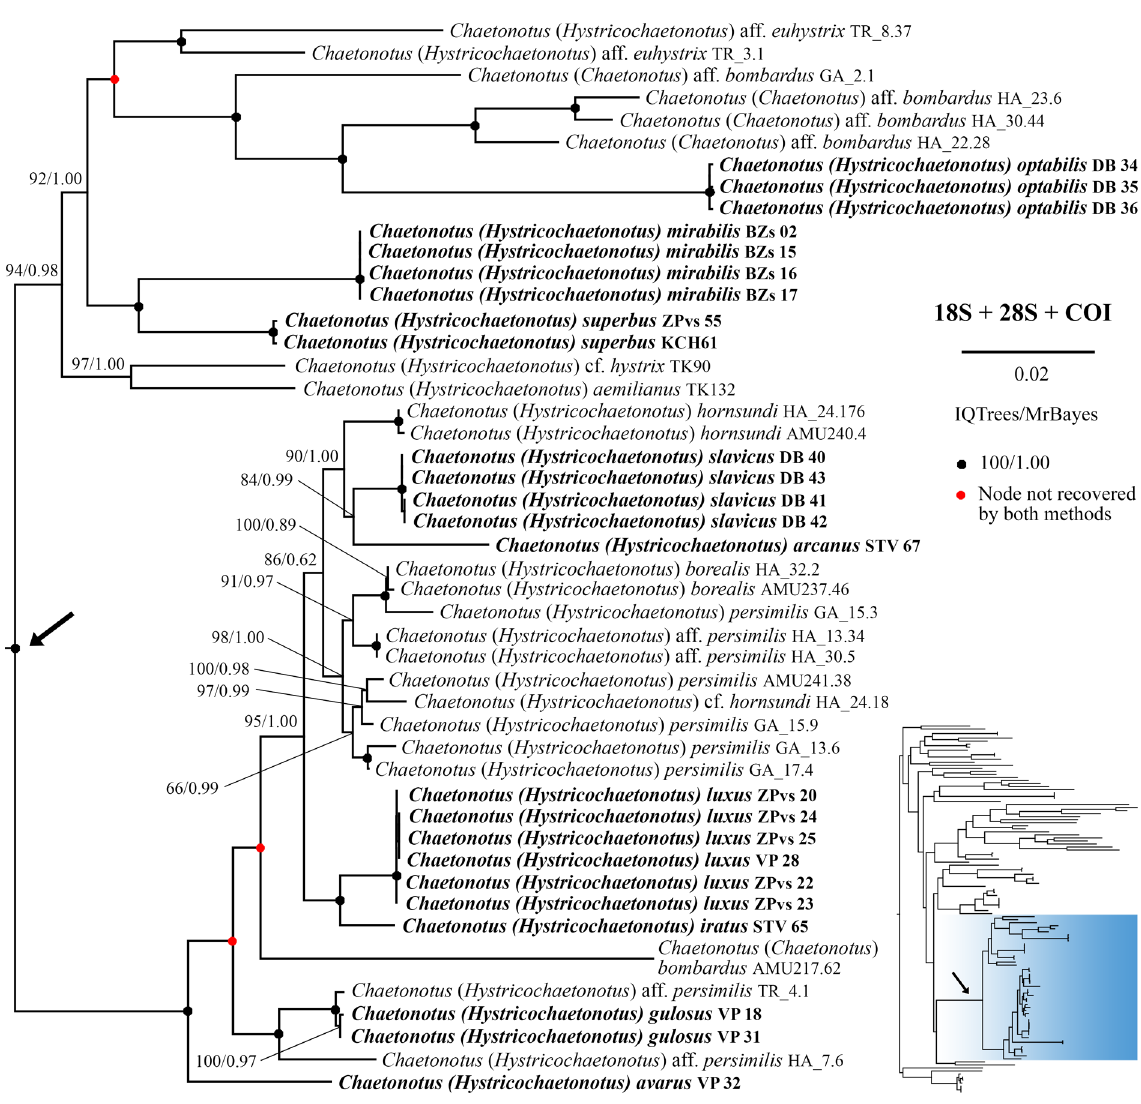
Fig. 9. Phylogenetic subtree based on 18S, 28S, and COI, showing the systematic positions of the nine new species within the Chaetonotus ( Hystricochaetonotus ) cluster. Arrows mark the same node in the subtree and the inset phylogram. The whole tree is presented in Fig. 8. The Chaetonotus ( Hystricochaetonotus ) cluster is highlighted in the inset phylogram. ML bootstrap values and posterior probabilities were mapped onto the best ML